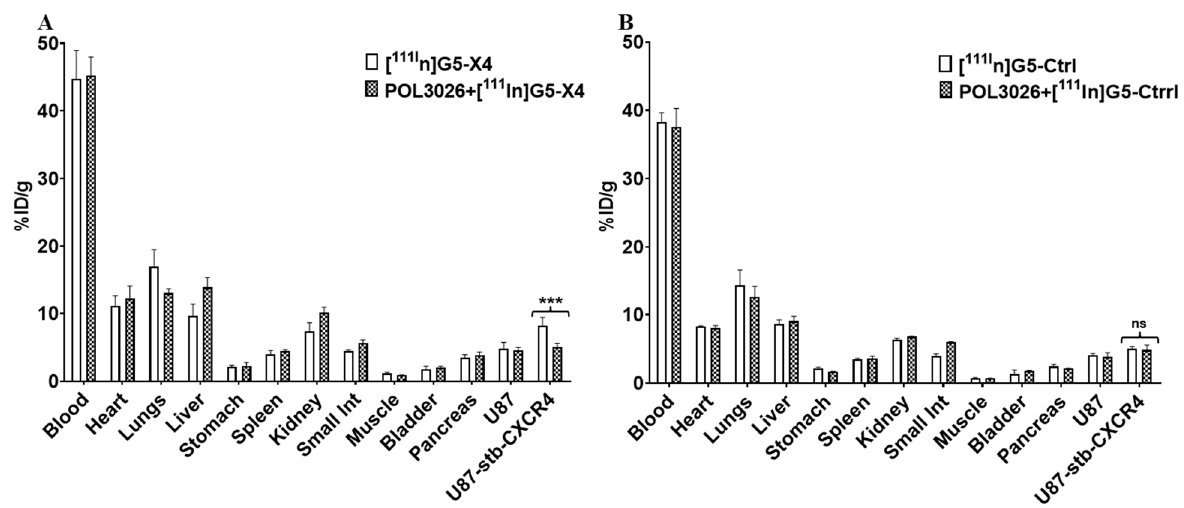
Figure 4. Evaluation of [ 111 In]G5-X4 in vivo specificity. For blocking experiments, mice were injected with 45 µg of unmodified POL3036 peptidomimetic 1 h prior to the administration of ( A ) [ 111 In]G5-X4 and ( B ) [ 111 In]G5-Ctrl radiotracers. Biodistribution was carried out at 3 h after radiotracer injection. Results indicate that uptake of [ 111 In]G5-X4 in CXCR4 positive tumors was blocked by POL3036 to the level detected in CXCR4 negative tumors and by [ 111 In]G5-Ctrl in both tumors. *** p < 0.01.